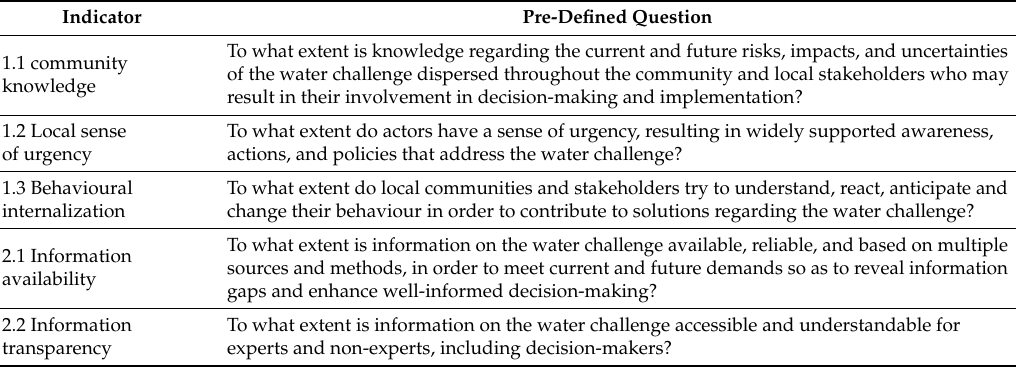
Table 2. Overview of pre-defined questions to be answered by the researcher based on a triangular approach consisting of three steps: (1) literature review; (2) in-depth interviews with selected